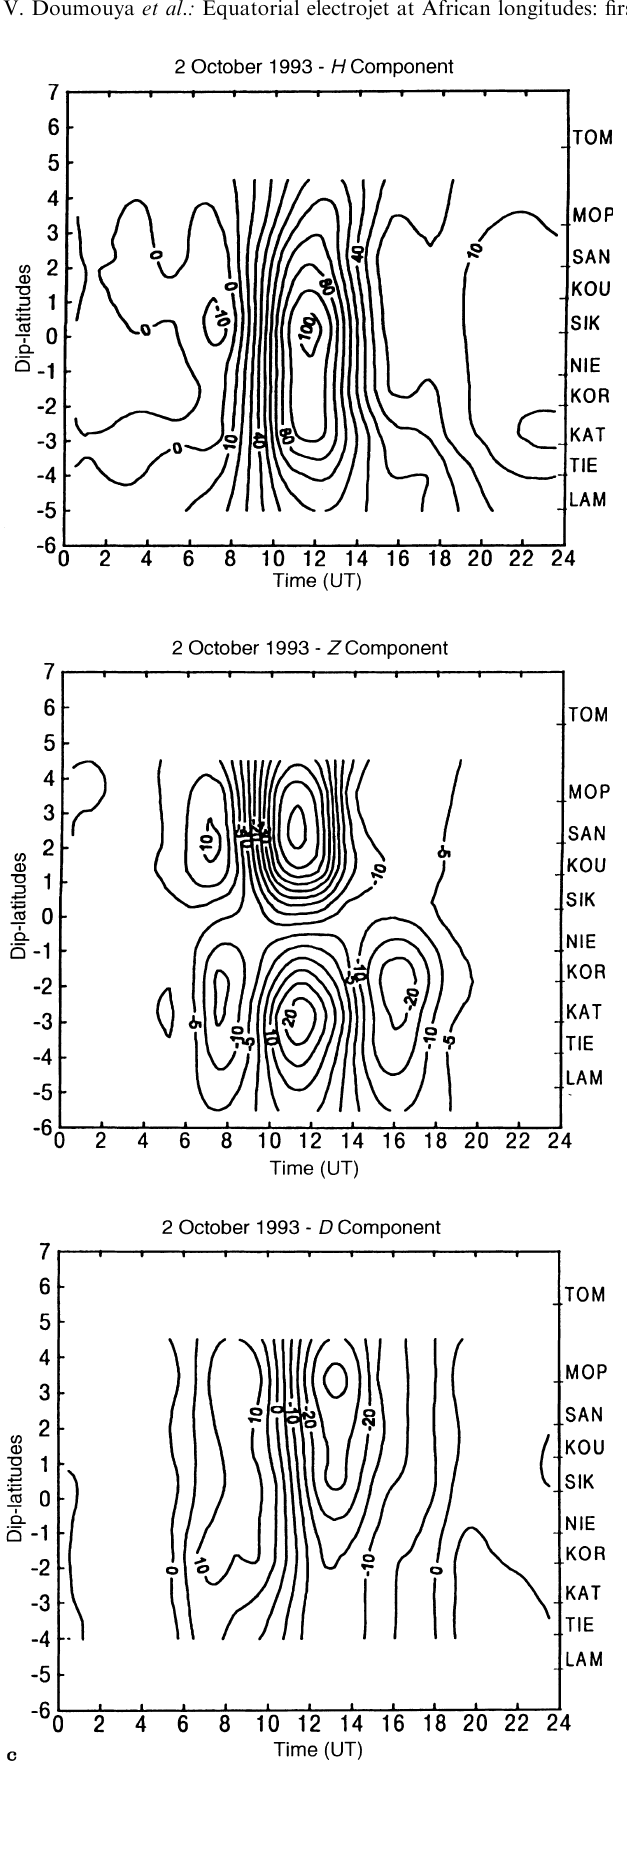
components are also shown. b Example this time of afternoon counter-electroject, for 20 June 1993. c For morning and afternoon counter-electroject, for 2